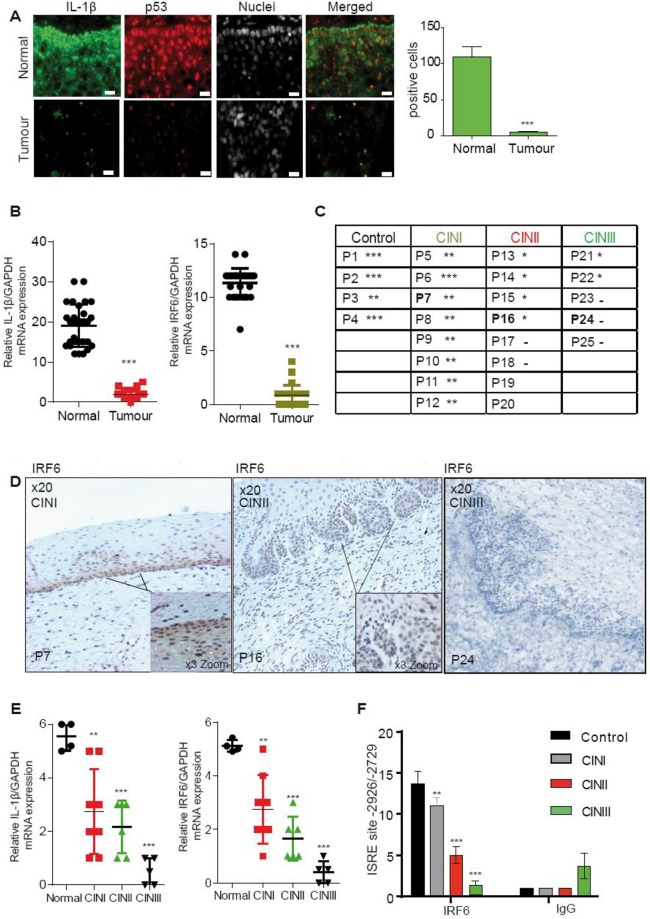
HPV16-positive cervical cancer lesions contain less IRF6 and IL-1β.(A) Immunofluorescence of normal cervical issue and HPV16+ cervical cancer biopsies. IL-1β (green), p53 (red) with trace indicating the basal layer and nucleus (white). Normal (HPV−) and a neoplastic biopsy (HPV16+) from one representative patient out of six with similar results are shown. Bars represent a scale of 10 μm. For each stained biopsy, six fields were examined IL-1β staining was counted manually and the percentage scored out of 100 cells. n = 4. (B) RNA was extracted from normal (29) and cervical cancer biopsies (29). IL-1β relative and IRF6 mRNA levels were measured by RT-qPCR. n = 4. (C) Table of immunohistochemical scoring IRF6 in patients at different stages of cervical neoplasia. Scoring, *** strong, ** medium, * low and—no staining (4 normal, 8 CINI, 8 CINII, 5 CINIII). n = 2. All tissue staining data were examined by two pathologists. (D), Immunohistochemical staining of IRF6 in cervical tissue in patients with CINI, II or III. n = 2. (E) RT-qPCR of IL-1β and IRF6 mRNA expression levels in normal vs neoplastic cervical tissue. n = 3. A p53 site is required to bind to the IRF6 promoter but is lost in cervical cancer tissues. (F) ChIP analysis was performed on normal and cervical neoplastic tissue for IRF6 binding on ISRE site on the IL-1β promoter. n = 3.